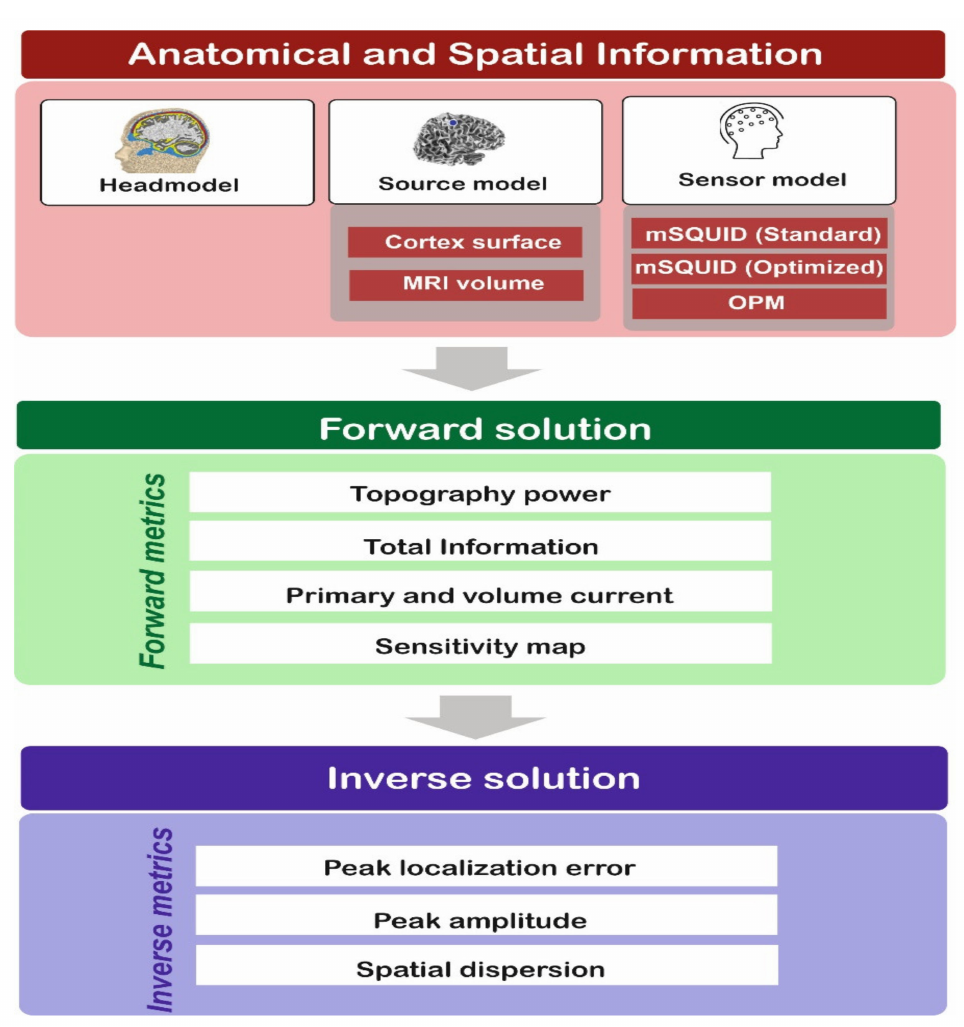
Figure 2. The steps in the comparative